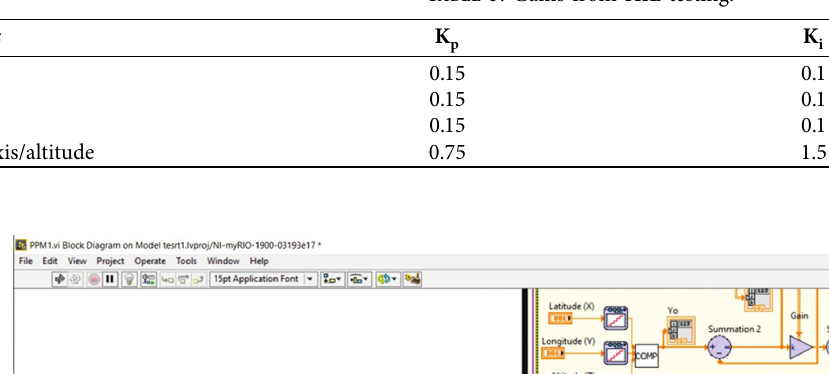
Table 5: Gains from HIL testing.